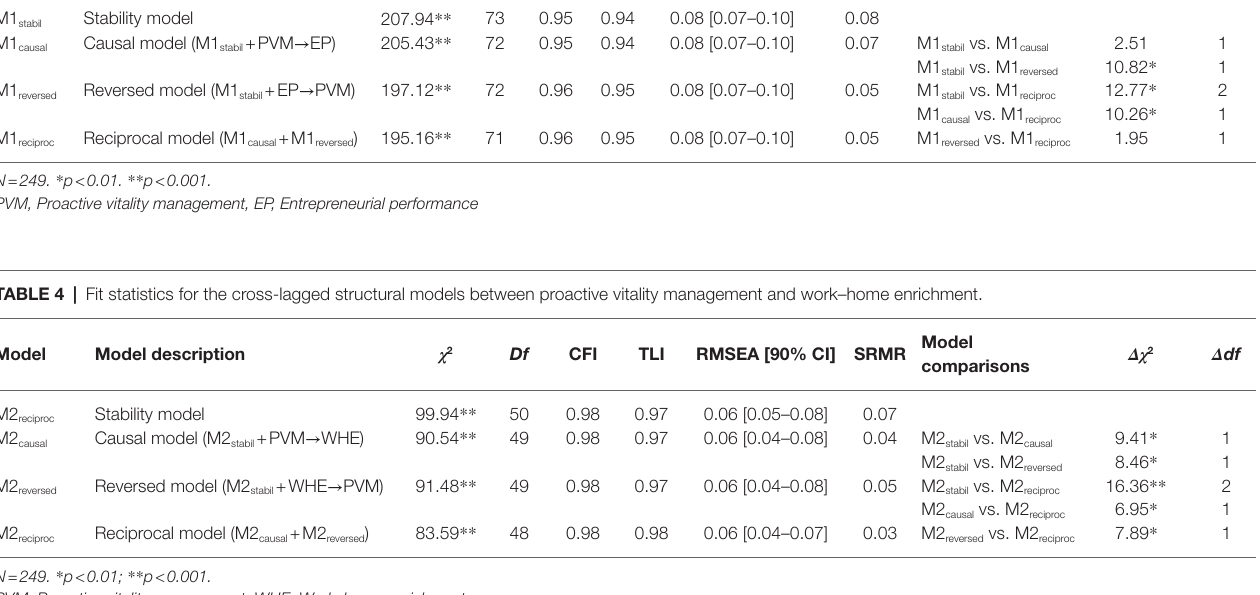
TABLE 3 | Fit statistics for the cross-lagged structural models between proactive vitality management and entrepreneurial performance. Model Model description